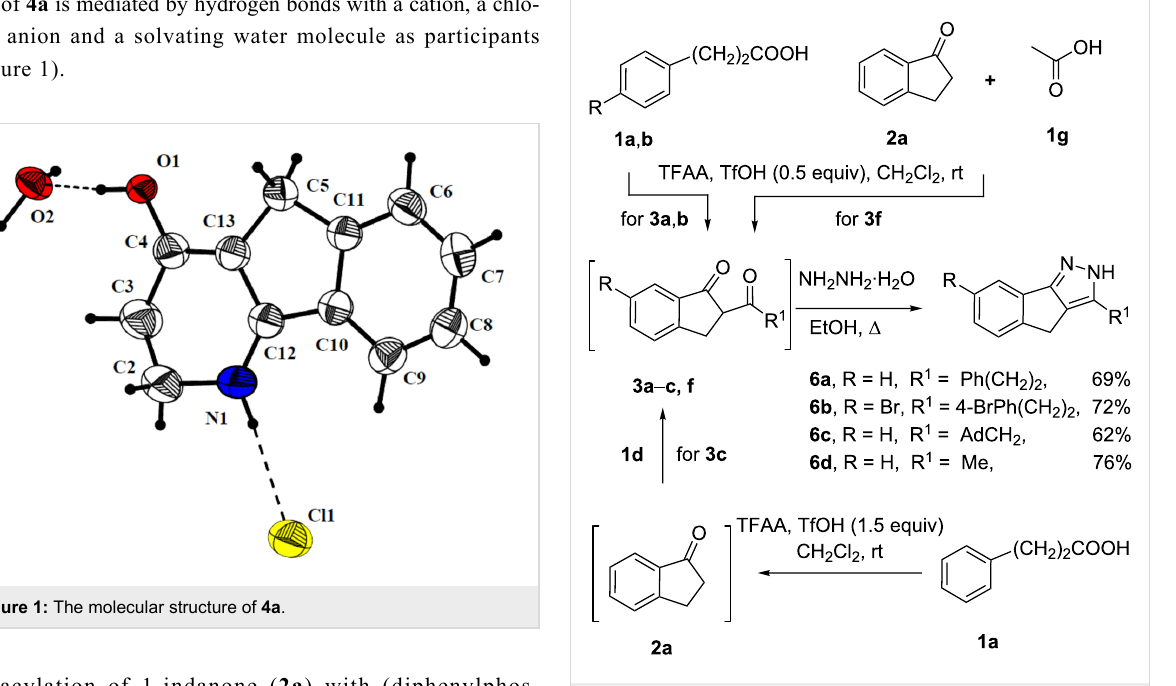
By acylation of 1-indanone ( 2a ) with (diphenylphos- phoryl)acetic acid ( 1j ), the self-acylation of the acid 1j already occurred at room temperature, which complicated the sep- aration of the desired dicarbonyl compound. When the acid 1j was heated under the conditions of TFAA/TfOH-mediated self- acylation of alkanoic acids recently reported by us [27] and decarboxylation was subsequently carried out, 1,3-diphenyl- phosphorylated acetone 5 could be obtained (reaction 2 in Scheme